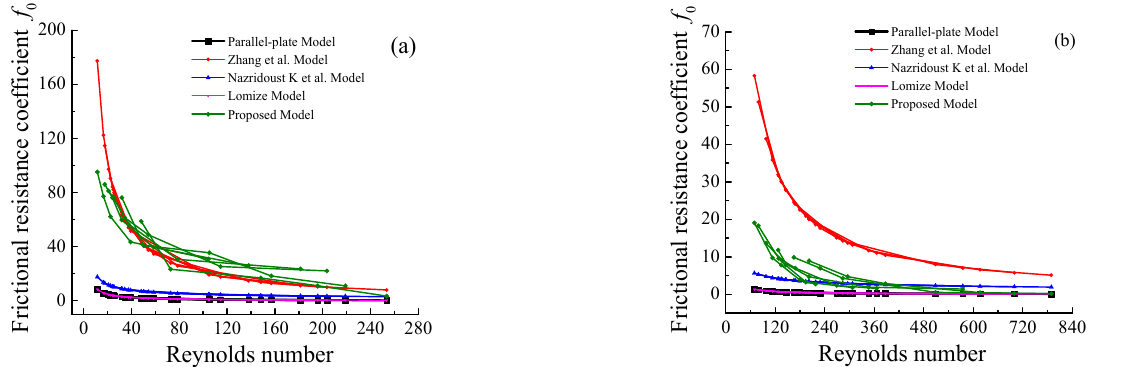
Zhang et al. Model Nazridoust K et al. Model